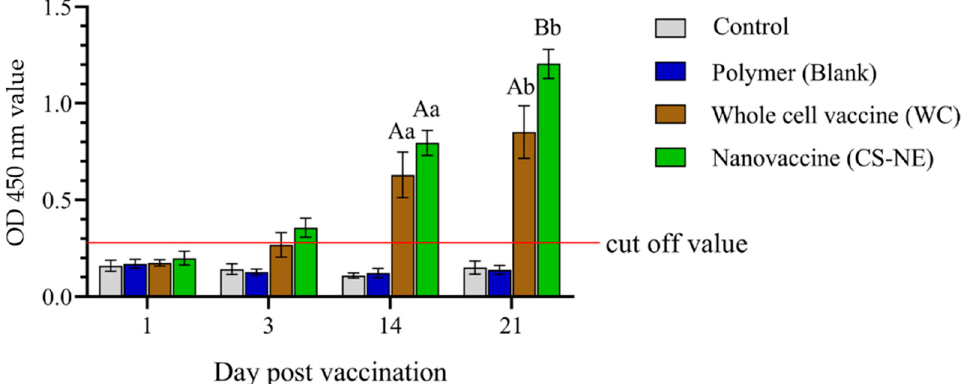
Figure 6. Identification of seropositive and seronegative fish amongst vaccine groups using an indirect ELISA. Different capital letters indicate significant differences at p < 0.05 among groups at each time point. Different small letters indicate significant differences over time within each group (N = 6). Two-way analysis of variance, and repeated measures analysis of variance followed by Bonferroni’s multiple comparison test were used for statistical analysis .